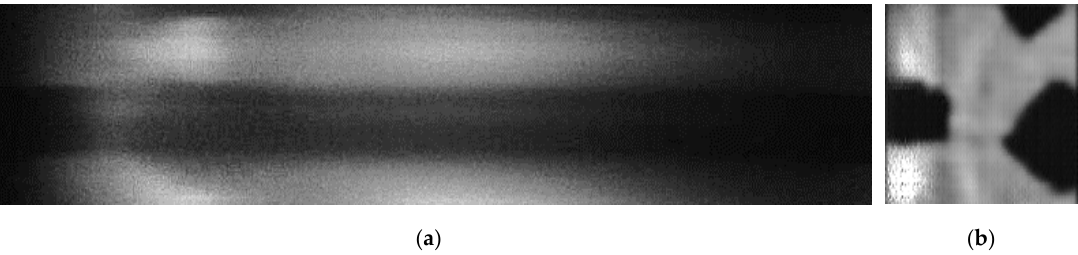
Figure 10. The results of actual experiments with 30 dB (analog gain of camera). ( a ) Overlapped dispersive spectra. ( b ) Reconstructed light intensity.